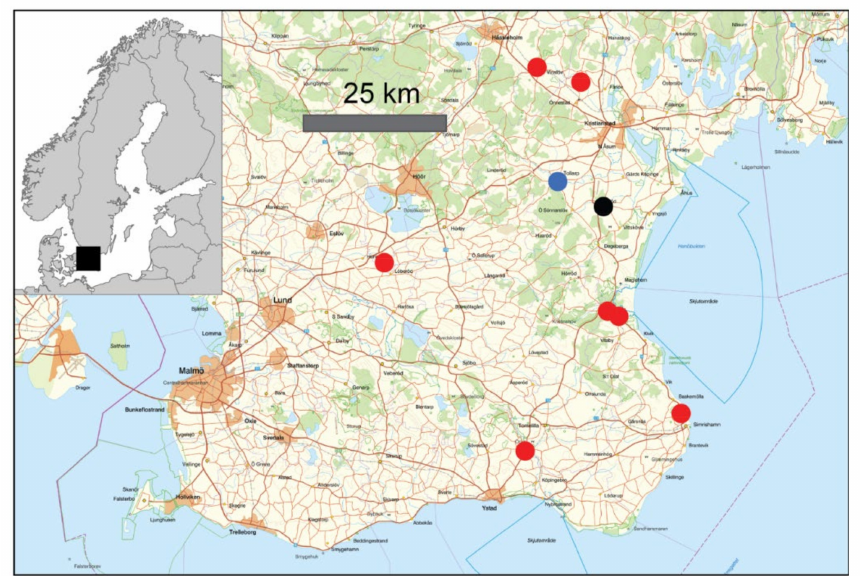
Figure 1. Spatial location of the nine bat trapping localities in southern Sweden. The black square in the map of Fennoscandia indicates the study area. Coloration of circles indicates the species that were trapped. Red circles: only Daubenton’s myotis ( Myotis daubentonii ), blue circle: M. daubentonii and Soprano pipistrelle ( Pipistrellus pygmaeus ), black circle: M. daubentonii , Pipistrellus pygmaeus and whiskered myotis ( M. mystacinus ). Table 1. Summary of the nine trapping localities as well as number of specimens per bat species